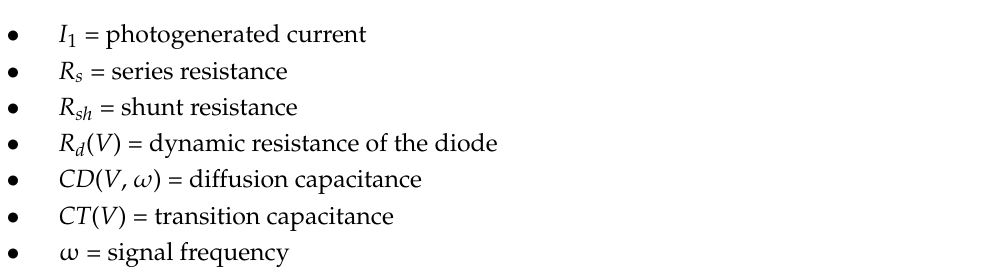
Figure 2. The AC equivalent electrical circuit of a solar cell.